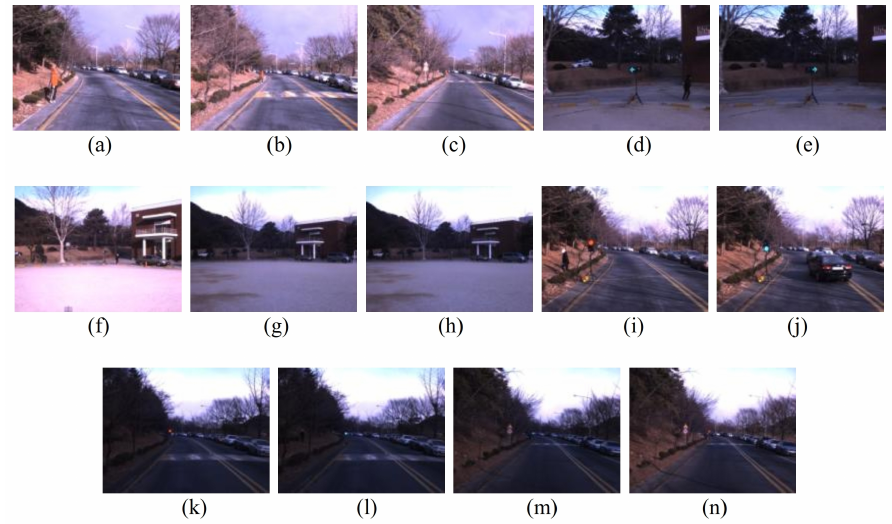
Figure 8. Colour Filter Array (CFA) images utilized for the evaluation of the proposed system.